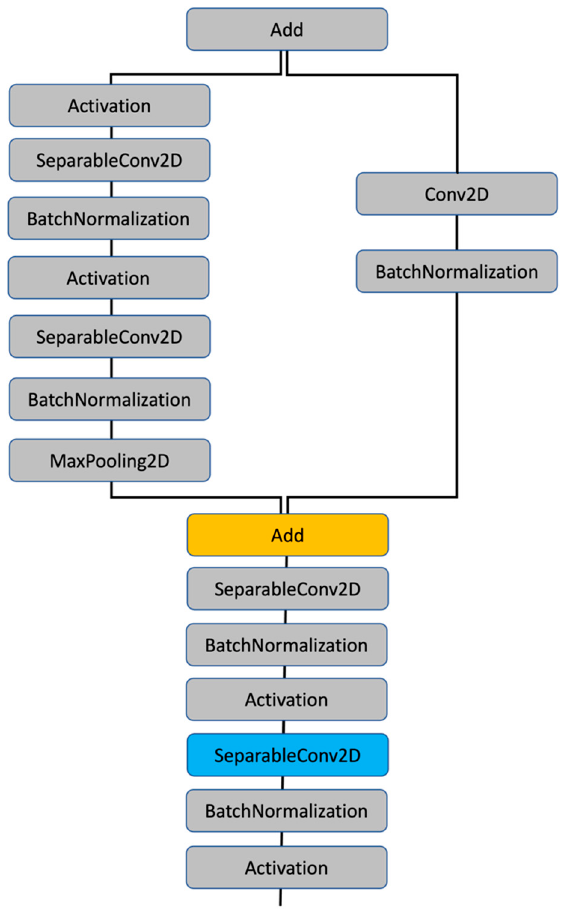
Figure 11. Partial illustration of Xception architecture.